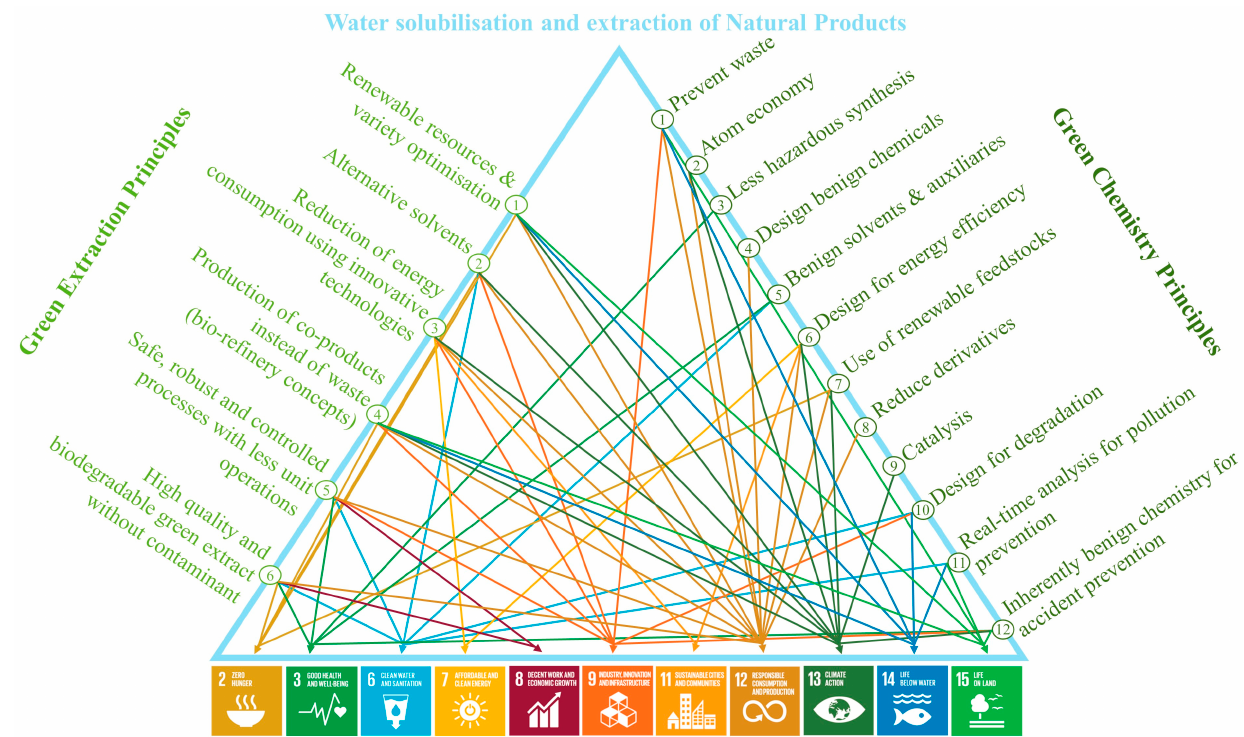
Figure 5. Contribution to the SDGs of the principles of green extraction and green chemistry related to the use of water as a solvent for solubilisation and the extraction of natural products. SDG 2: Zero Hunger; SDG 3 Good Health and Well-being; SDG 6: Clean Water and Sanitation; SDG 7: Affordable and Clean Energy; SDG 8: Decent Work and Economic Growth; SDG 9: Industry, Innovation and Infrastructure; SDG 11: Sustainable Cities and Communities; SDG 12: Responsible Consumption and Production; SDG 13: Climate Action; SDG 14: Life Below Water; SDG 15: Life on Land.